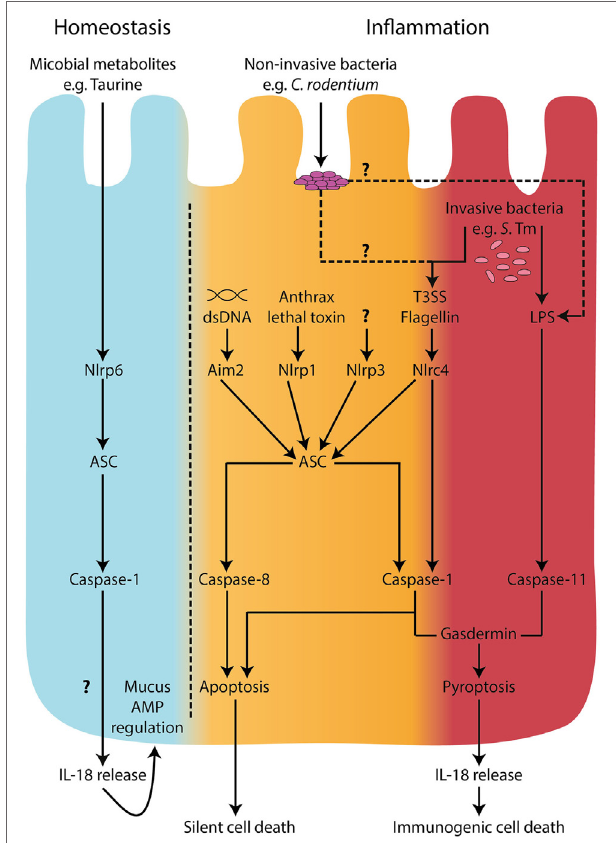
FigURe 1 | Inflammasomes in intestinal epithelial cells. During homeostatic conditions, in the absence of inflammation, IL-18 is released from epithelial cells and is involved in epithelial repair, proliferation, and maturation (33, 34). A metabolomics screen identified microbiome-derived metabolites, including taurine, that are capable of modulating NLRP6 inflammasome activation and subsequent IL-18 secretion (32). However, the mechanisms of release of IL-18 during homeostatic conditions are undefined. In the context of microbial invasion and pathogen-associated molecular pattern stimulation, inflammasome activation in intestinal epithelial cells has been described to engage both “canonical,” caspase-1-mediated and “non-canonical,” caspase-11 pathways (14, 24, 44). Recently, caspase-8 was also shown to be involved in inflammasome responses downstream of NLRC4 engagement with intracellular flagellin (24). Both caspase-1 and caspase-11 can lead to cell death by pyroptosis accompanied by IL-18 secretion; however, caspase-1 and caspase-8 were shown to lead to a non-lytic form of cell death upon NLRC4 sensing of intracellular flagellin (24). These observations raise the possibility of a distinction between a pro-immunogenic cell death signal driven by caspase-11 and GsdmD, a pro-silent cell death driven by caspase-8, and perhaps a threshold-dependent cellular decision between non-lytic and lytic forms of cell death involving caspase-1. Under low stress levels, it would be desirable to deal with the invading threat in an immunologically silent way. However, when the threat is high, an immunogenic cell death could recruit inflammatory cells to help clear the microbial